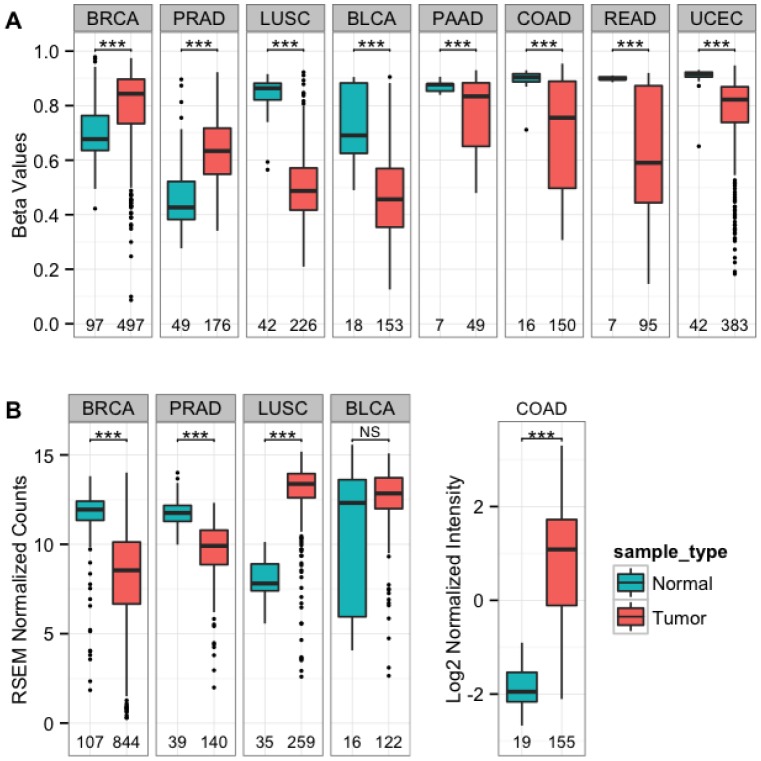
Bidirectional “switch” in TRIM29 regulation from normal epithelium to the respective carcinomas.TCGA data analysis: (A) TRIM29 promoter methylation (average of 5 Illumina probes, Table S4B) in normal and in cancer tissues. Partial methylation was noted in breast and prostate normal tissues that increased in the respective cancers. In contrast, for the other tissue-types, methylation was high in the normal tissues and decreased in the respective carcinomas. (B) For breast and prostate cancers, increase in promoter methylation was associated with decrease in gene expression whereas the opposite was noted for the other tissues. BRCA = breast carcinoma, PRAD = prostate adenocarcinoma, LUSC = lung squamous cell carcinoma, BLCA = bladder carcinoma, PAAD = pancreatic adenocarcinoma, COAD = colon adenocarcinoma, READ = rectal adenocarcinoma UCEC = uterine-cervix carcinoma. Number of samples indicated at the bottom, ***p<0.0001, NS – not significant, P-values between groups were calculated using Welch's corrected t-test.